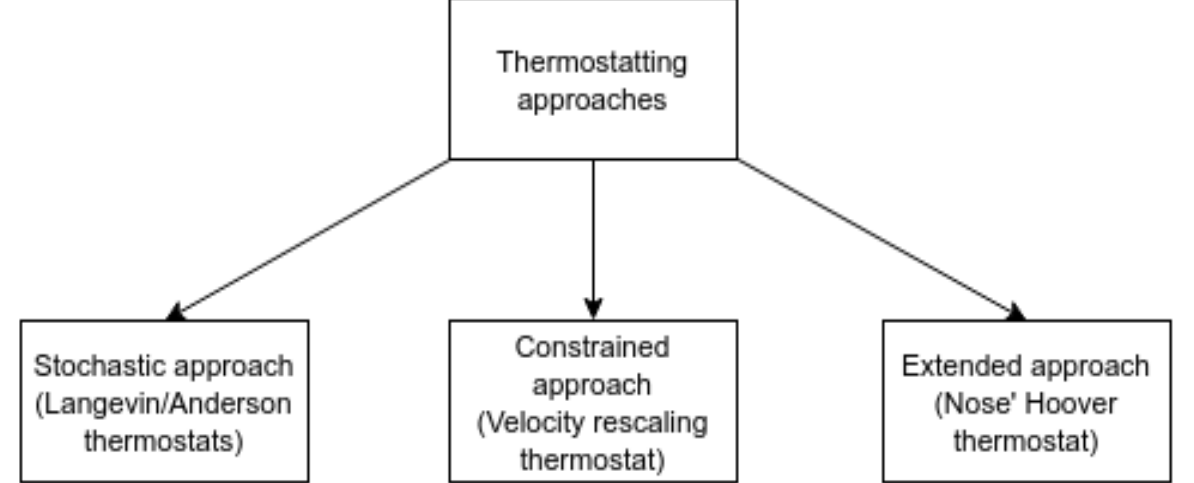
Figure 2. Classification of thermostats.